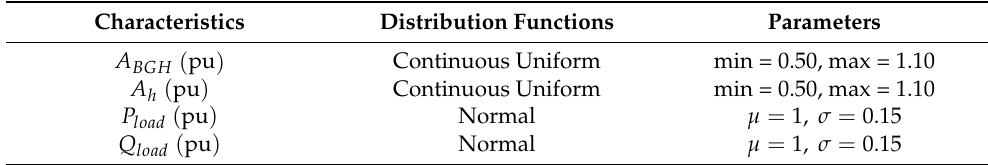
Table 6. The MCS distribution functions and parameters